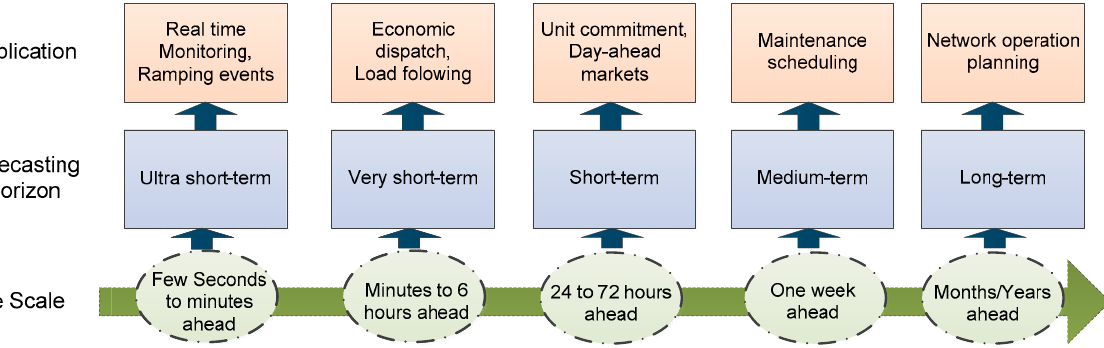
Figure 1. Forecasting applications and their associated time scales and forecast horizons.